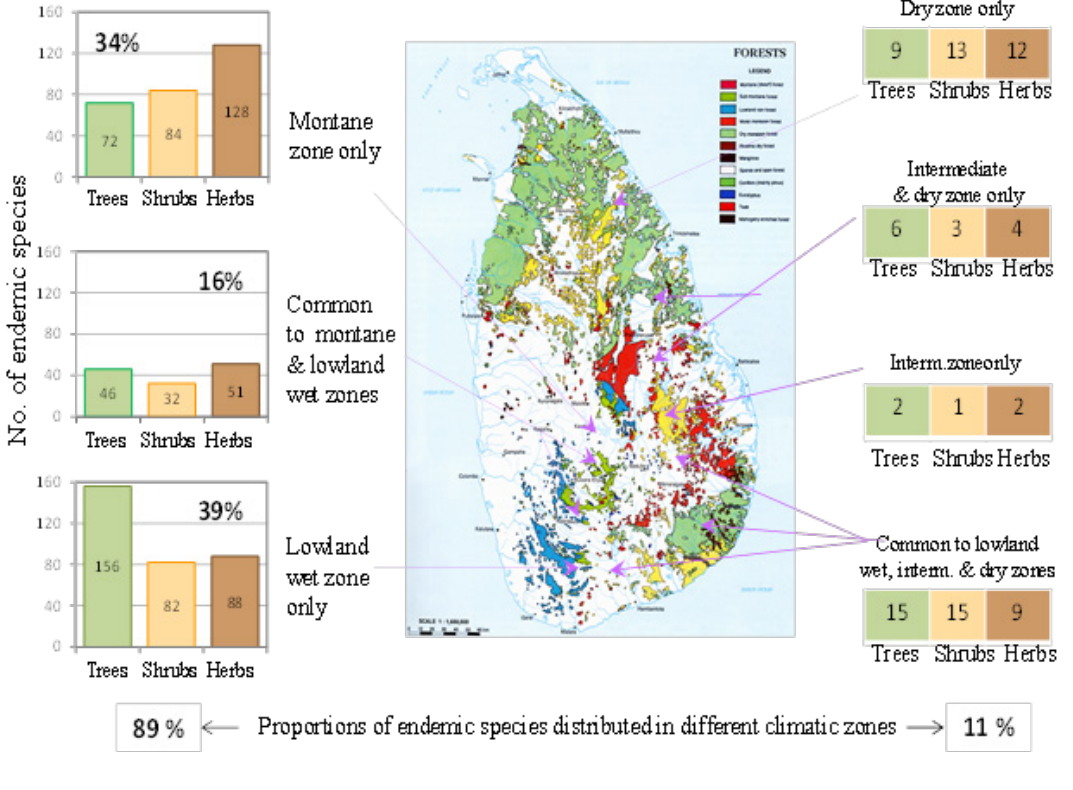
Figure 5: Distribution of the number of endemic tree, shrub and herbaceous species among the different major climatic zones of Sri Lanka.